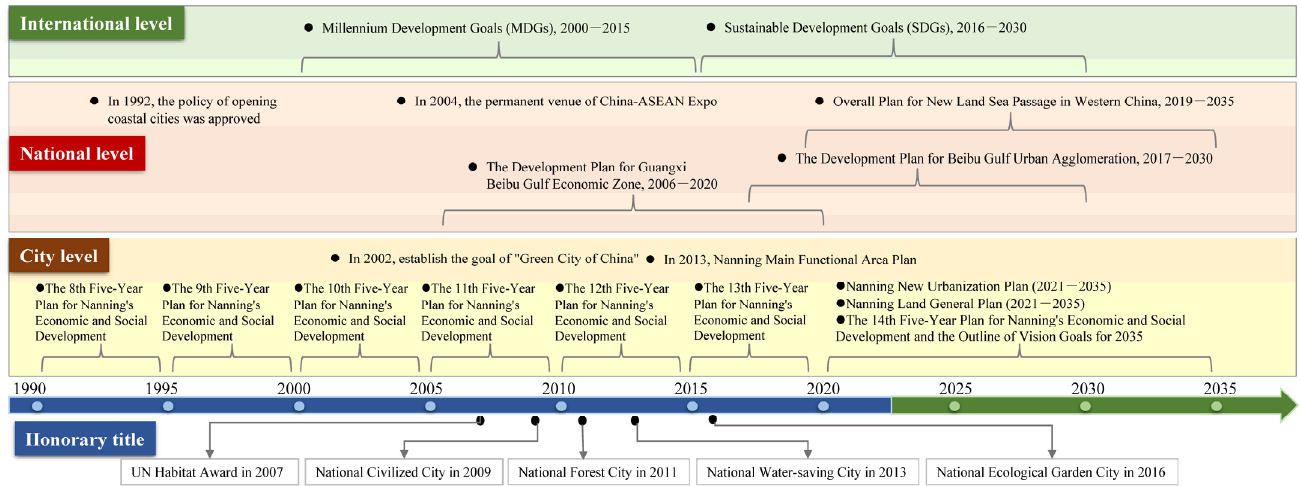
Figure 9. Nanning’s urban development policies and its awards.